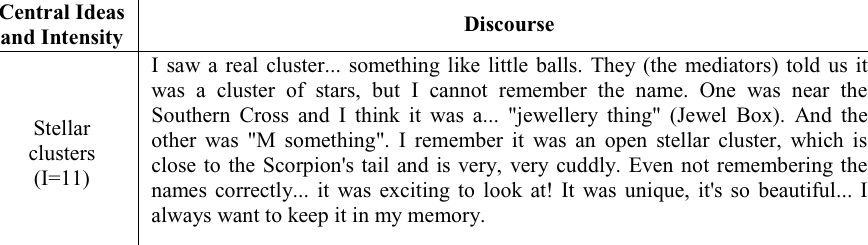
Table 3. Discourse on the observation of stellar clusters.